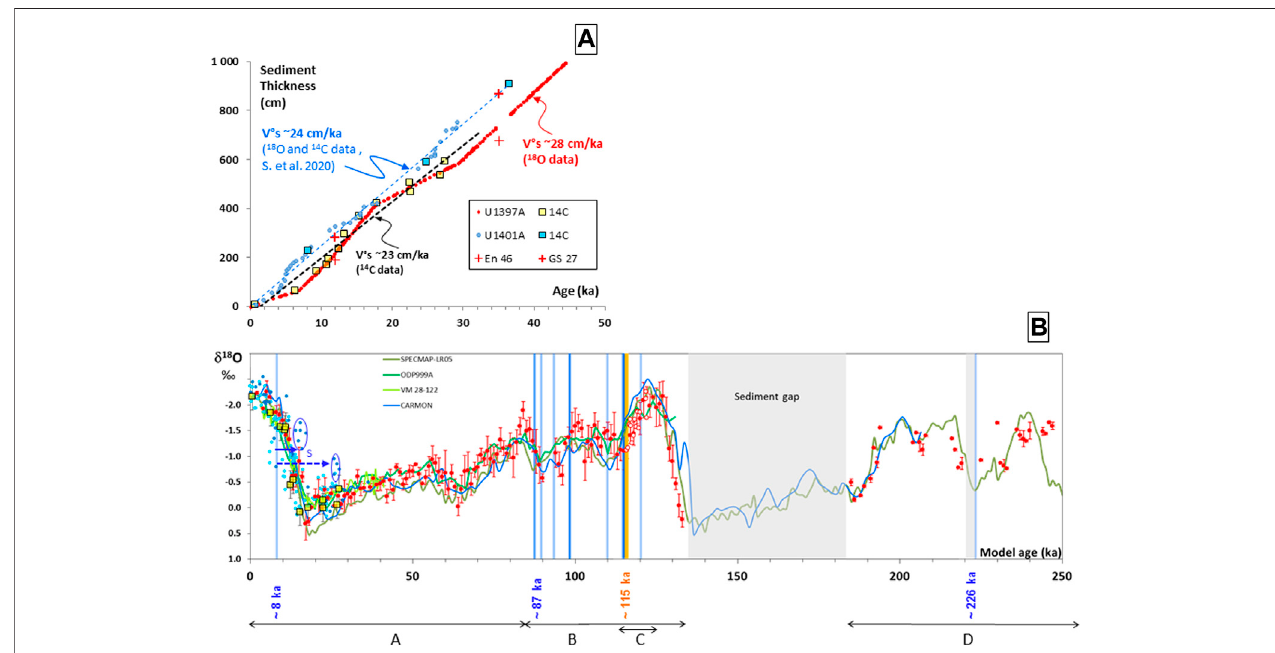
FIGURE5 | Model age and sedimentationrate ofcore U1397A. Comparison with core U1401A. (A) Sedimentationrates: δ 18 O data; red dots: U1397A; blue dots: U1401A (data from Solaro et al. (2020)). Squares: 14 C data; yellow: U1397A; blue: U1401A. V ° S : mean hemipelagic sedimentation rates. Crosses: data of cores En 46 andGS27(biochronology,twovaluespercore;Reidetal.,1996;seealso Figure8 ). (B) ModelageofcoreU1397A δ 18 Odata:reddots:U1397A(meanvalueswitherror bars for asampling stepof1 cm); openred circles: sedimentary unitsdisplacedby submarine sliding( “ duplicateunits ” );lightblue dots: CARMAR-4 (Boudon et al., 2013); dark blue dots: U1401A (model age from Solaro et al., 2020); continuous green and blue lines: standard δ 18 O – age patterns (SPECMAP, ODP-999, VM 28-122, CARMON). Yellow squares: 14 C data (age errors are within symbol size). Blue bars: turbidites > 50 cm; orange bars: debrites; gray domain: erosion or sedimentation gaps; open circles: duplicate hemipelagic unit. Blue ellipses: the two anomalous δ 18 O patterns in core U1401A considered stratigraphically discordant units. Letters are the different lithological units (see Figure 3A ). See also Figure 4 and the text for further explanations.